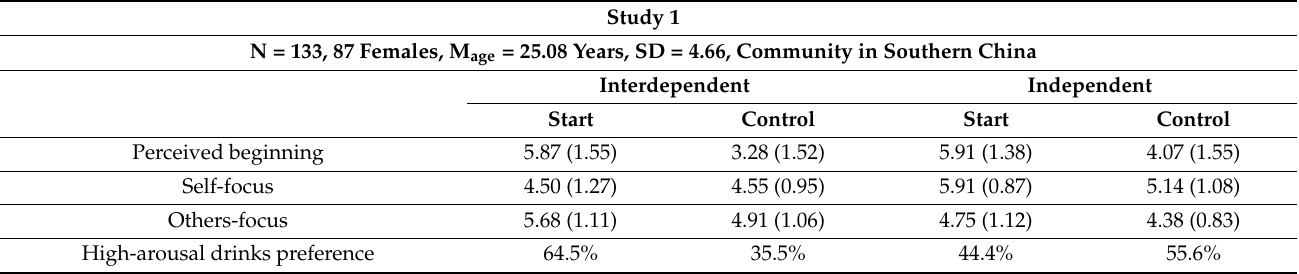
Table 3. Statistics descriptive results in Study